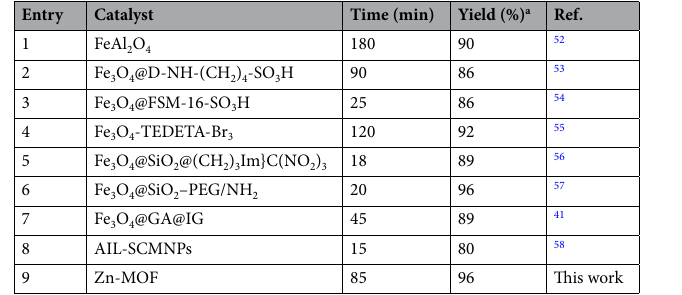
Entry Catalyst Time (min) Yield (%) a